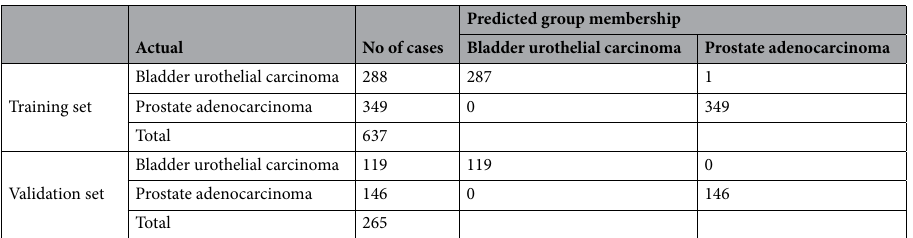
Table 5. Hit ratios for the model based on prostate lineage gene expressions. 99.8% of training set cases correctly classified. 100% of validation set cases correctly classified.